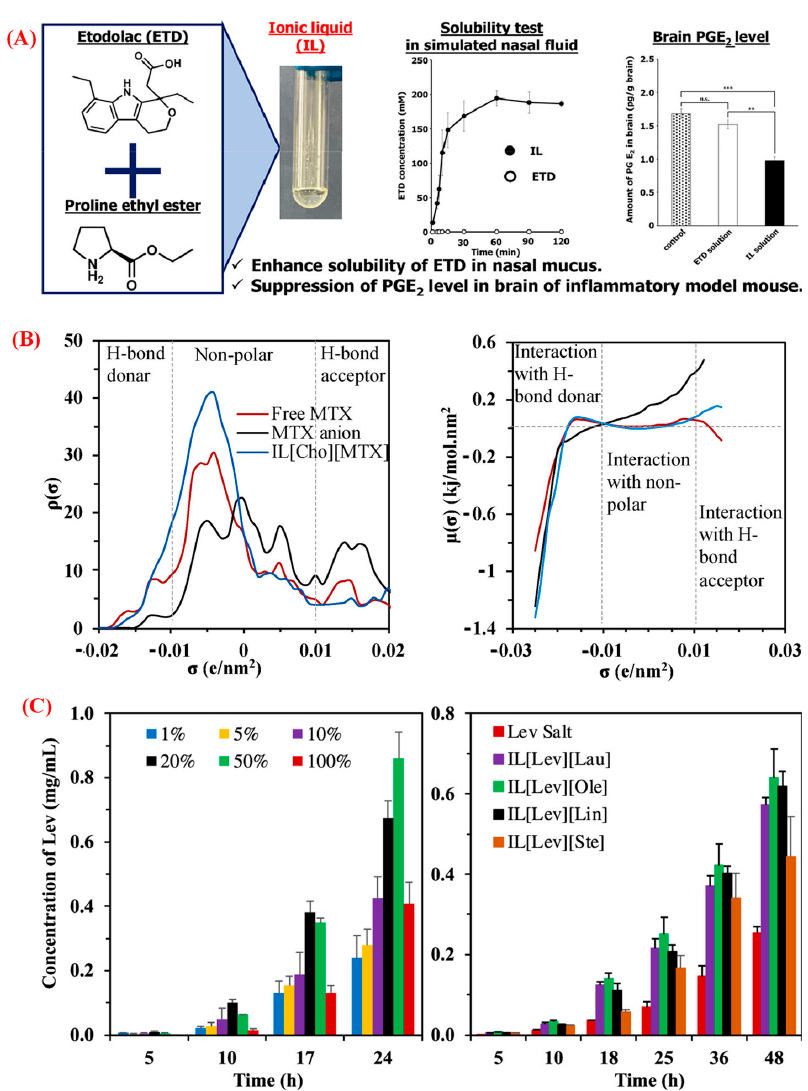
Figure 6. Schematic representation of the biopharmaceutical properties of ( A ) etodolac- containing API-ILs. Data represented as mean ± SD for n = 5 and *** p < 0.001, ** p < 0.01, n.s. p > 0.05 [76]; ( B )